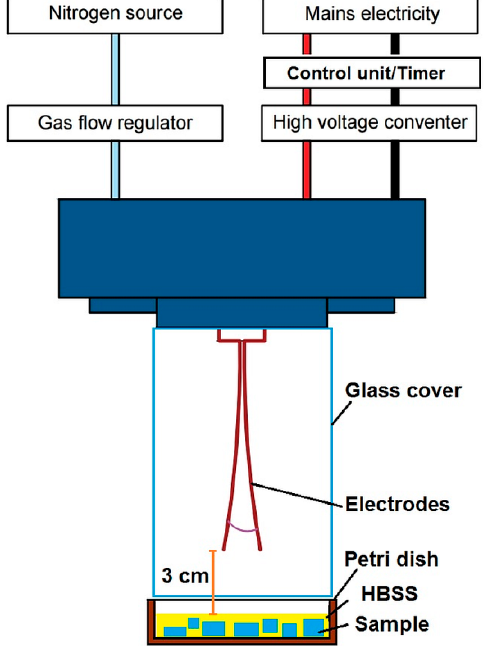
Figure 9. Scheme presenting plasma treatment set-up.